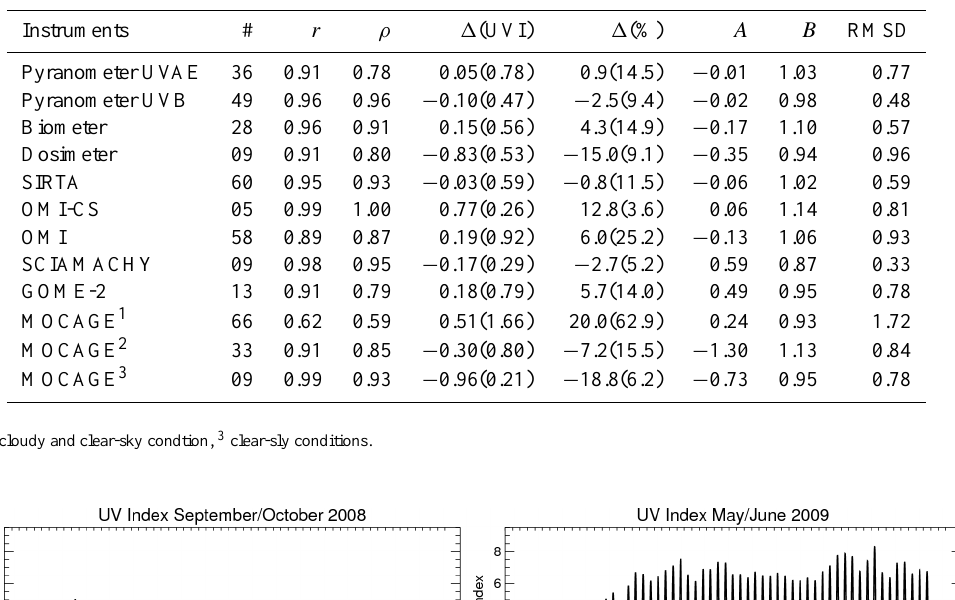
Table 3. Statistics for the RISC-UV campaigns. #: number of measurements. r : Pearson’s correlation coefficient. ρ : Spearman’s rank correlation coefficient. 1 (UVI), 1 (%): absolute and relative mean difference (standard deviation into brackets) with spectrometer chosen as reference. A and B : linear regression coefficients using a “robust” least absolute deviation method ( y = A + Bx ). RMSD: root mean square difference between the instruments and the spectrometer chosen as reference.